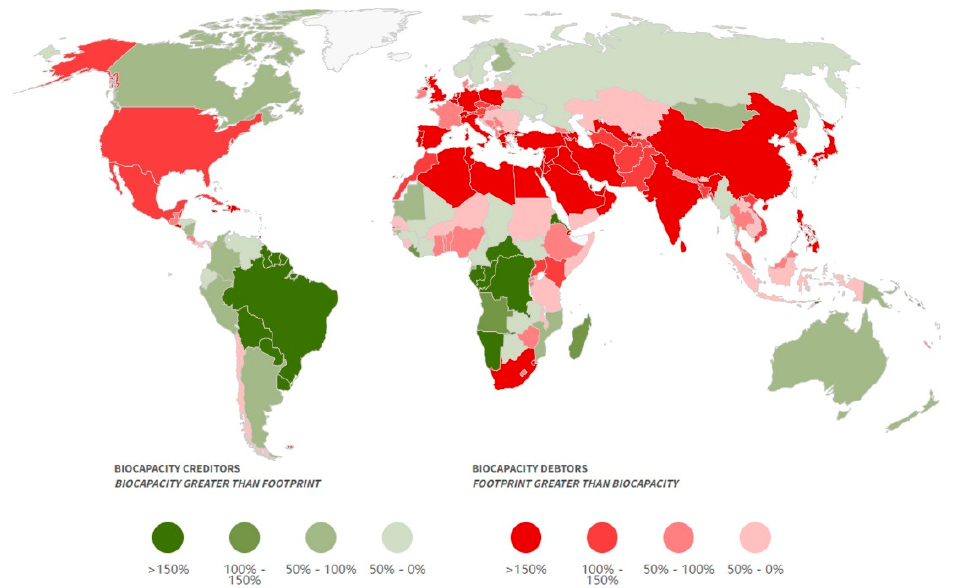
Figure 1. Ecological deficit/reserve. Source: Global Footprint networks, 2022.